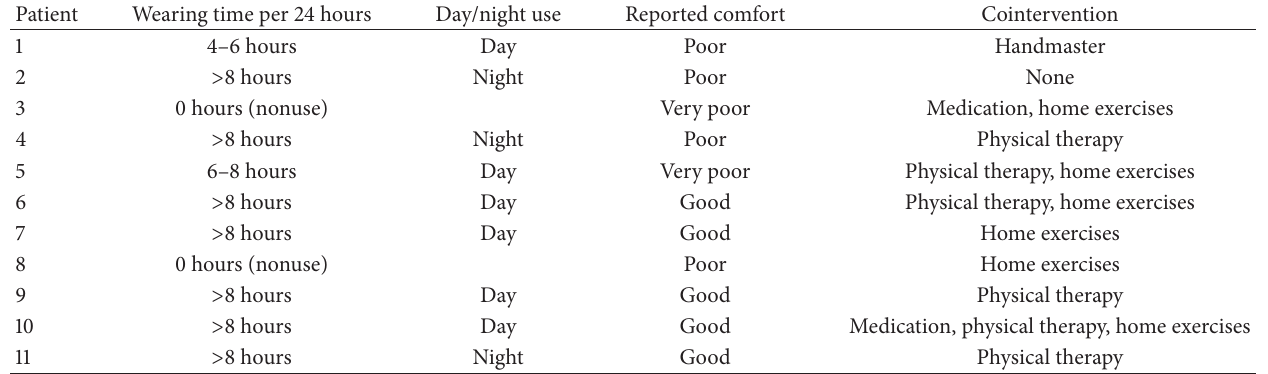
Table 1: Orthosis wearing time, experienced comfort, and the reported cointerventions in addition to the use of the orthosis.